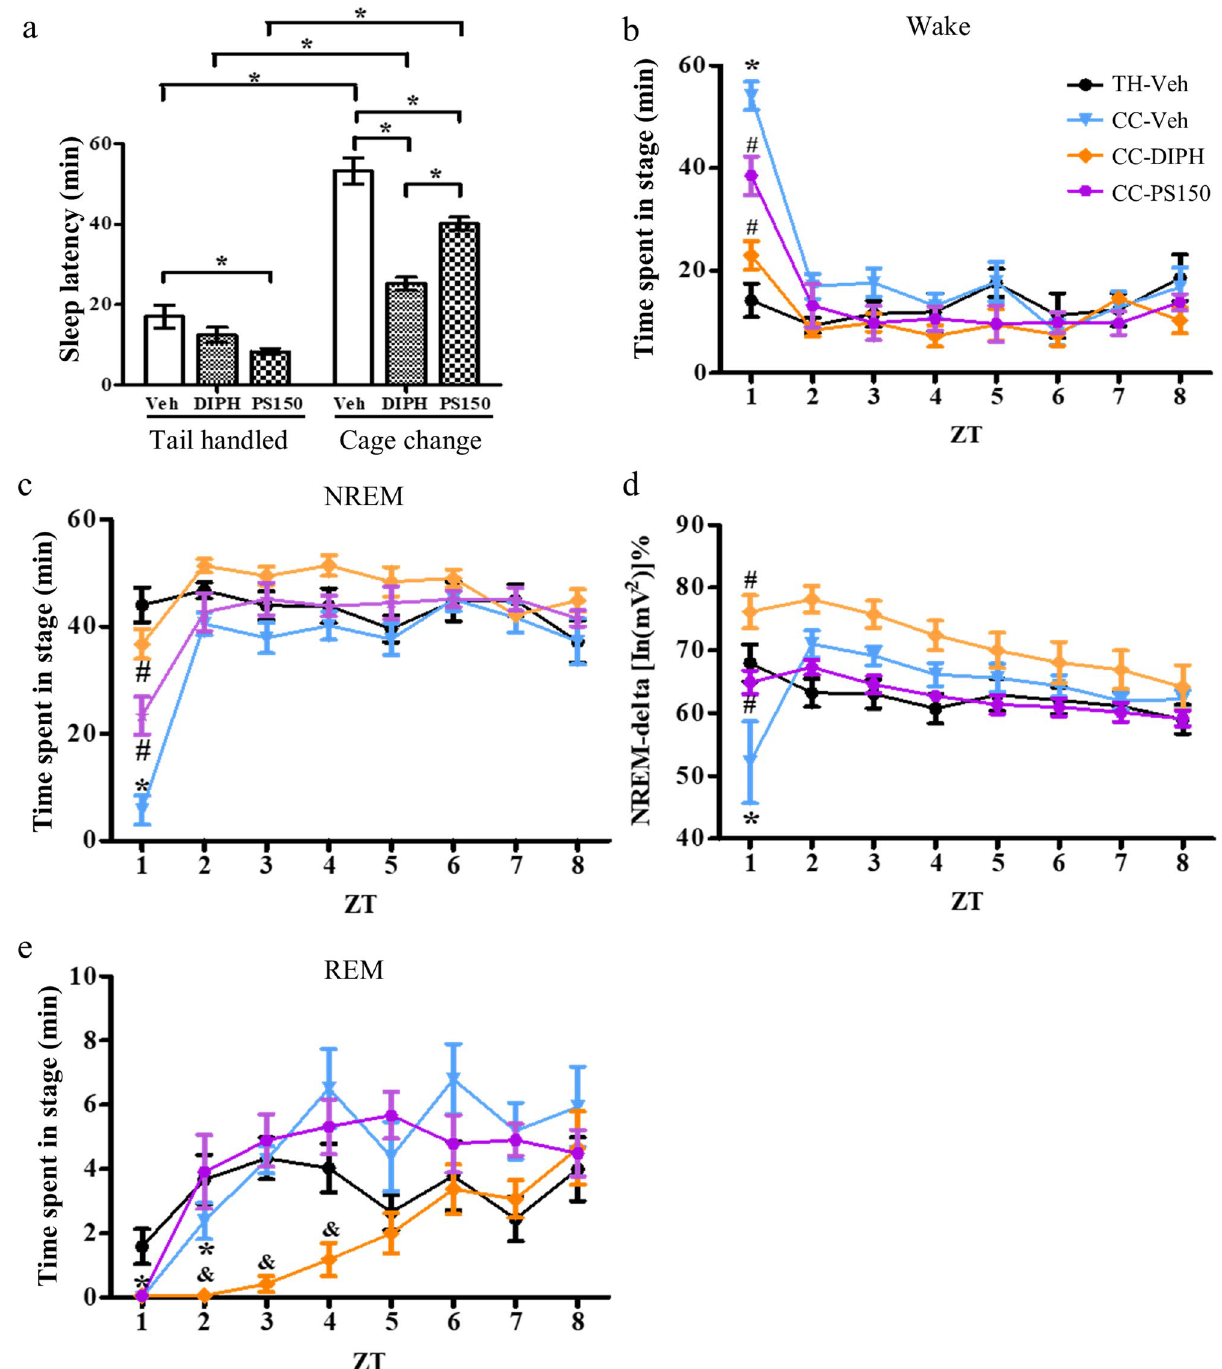
Figure 4. Time-dependent alterations in vigilance and sleep stages during the light phase. (a) Sleep latency of each group. Latency was defined as the time between the cage change procedure and the first non-rapid eye movement (NREM) sleep that lasted longer than 5 min. (b,c) The amount of wake and NREM states in each hour. Data from the unchanged control (TH-Veh), cage change control (CC-Veh), cage change positive control (CC-DIPH), and cage change PS150-treated (CC-PS150) groups are colored black, blue, orange, and violet, respectively. (d) The relative intensity of NREM-delta power in each hour. (e) Accumulated amount of REM states in each hour. Data are expressed as the mean ± SEM ( n = 7–9). For sleep latency, data were analyzed using two-way ANOVA with Bonferroni correction. For the effect of treatment in each hour, data were analyzed using one-way ANOVA with Tukey’s post hoc test. (* p < 0.05, compared to TH-Veh; # p < 0.05, compared to CC-Veh. & p < 0.05, compared to CC-Veh and